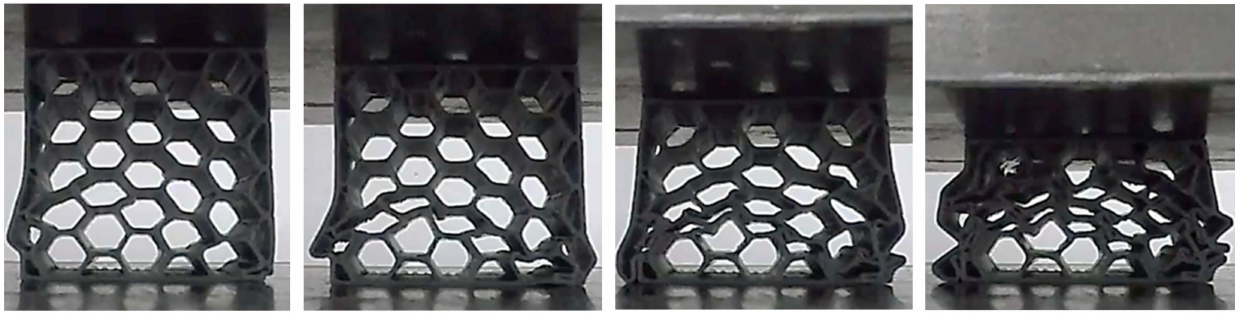
Figure 16. Experimentally-observed deformation sequence of the regular-scale hexagonal honeycomb sample under lateral load.